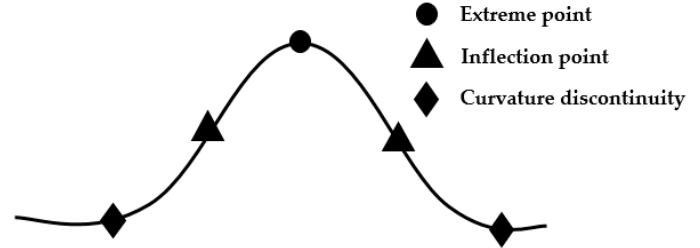
Figure 2. Feature points of curve .